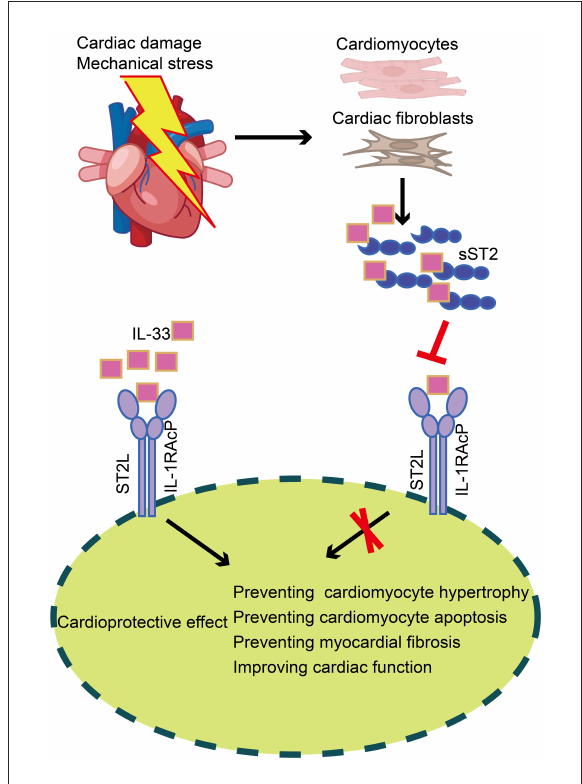
FIGURE4 Production and role of sST2 in cardiac tissue. In cardiac tissue, IL-33 binds to a receptor complex composed of ST2L and IL-1RAcP, preventing cardiomyocyte hypertrophy, apoptosis, and myocardial fibrosis, thus improving cardiac function. On the other hand, cardiomyocytes and cardiac fibroblasts secrete sST2 when the heart is subjected to damage or mechanical stress. SST2 may bind free IL-33, substantially reducing the amount of IL-33 accessible for ST2L binding, thereby attenuating the cardioprotective effect of IL-33. sST2, soluble suppression of tumorigenicity; IL-33, Interleukin-33; ST2L, transmembrane isoform of suppression of tumorigenicity 2; IL-1RAcP, IL-1 receptor accessory